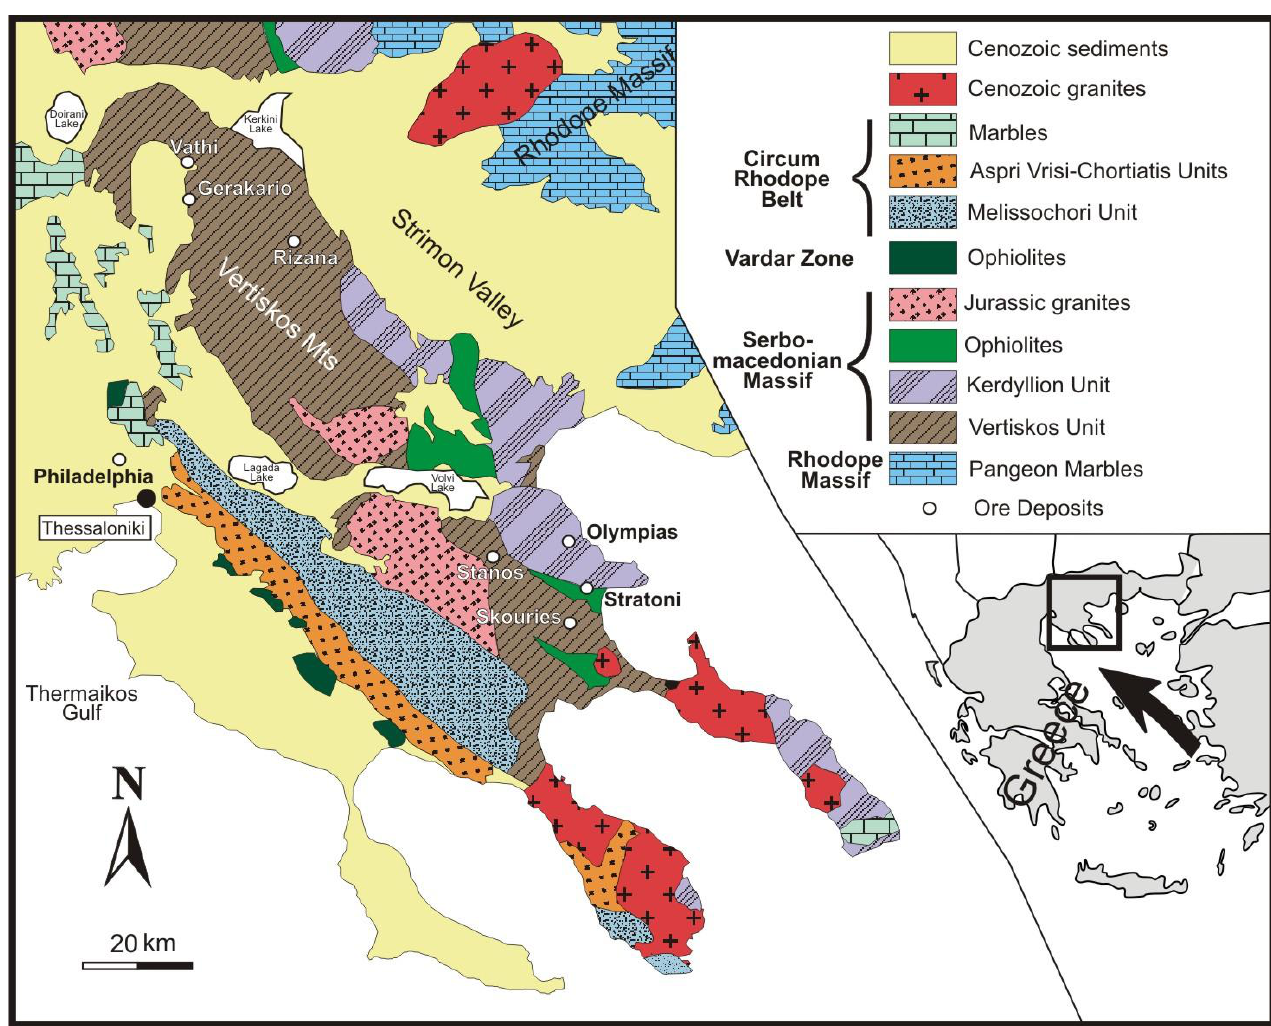
Figure 2. Simplified geological map of the Serbomacedonian metallogenic province in Greece, displaying the major ore deposits and